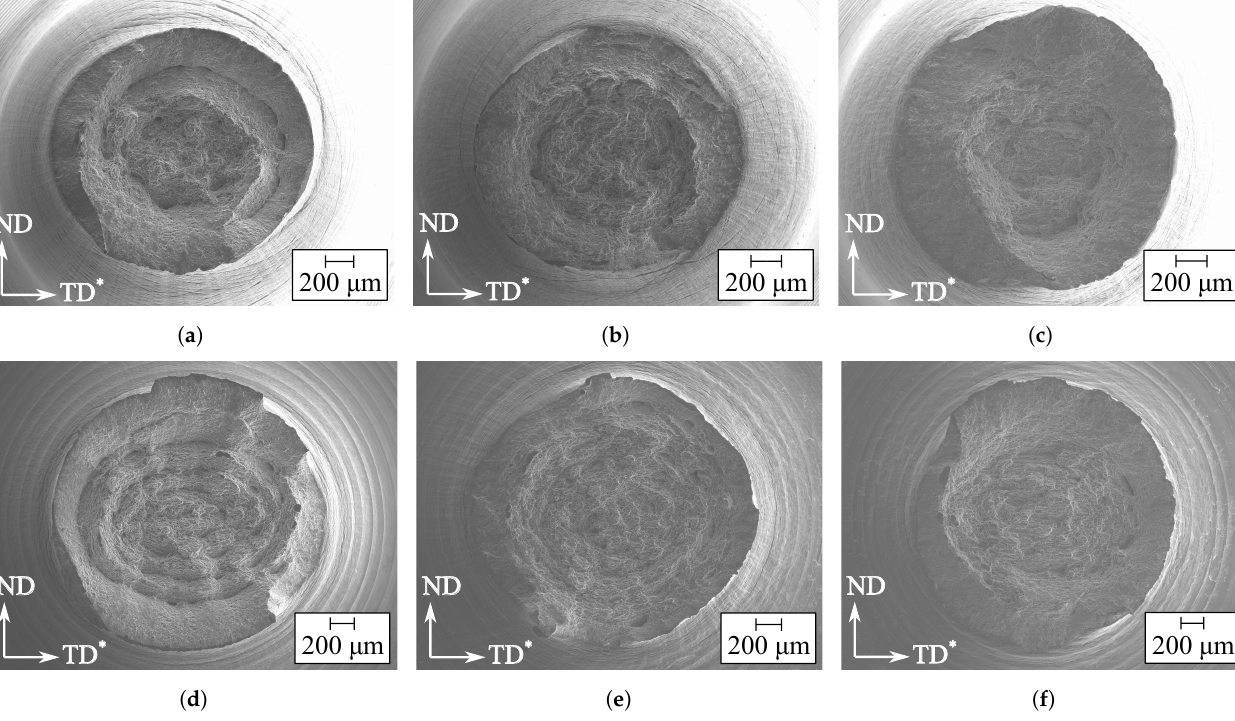
Figure 14. Fracture surfaces of representative tension tests for alloy AA6110. ( a ) Smooth, 0 ◦ , ( b ) Smooth, 45 ◦ , ( c ) Smooth, 90 ◦ , ( d ) R0.8, 0 ◦ , ( e ) R0.8, 45 ◦ , ( f ) R0.8, 90 ◦